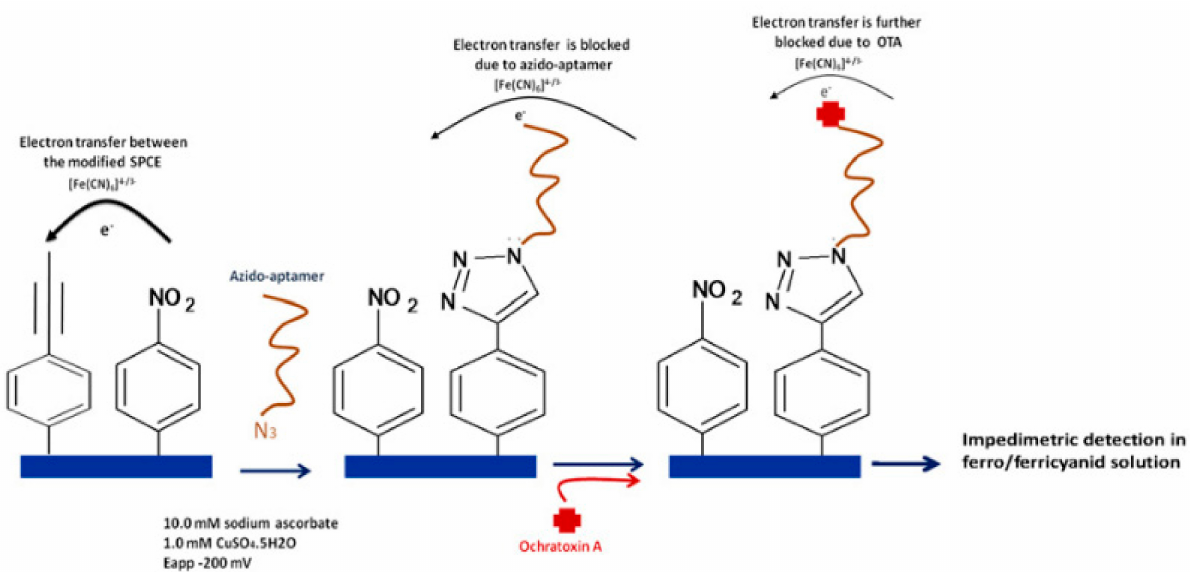
Figure 7. Design and working principle of an impedimetric aptasensor for OTA. The aptamer was immobilized through a “click” reaction at a phenylethynyl layer grafted through diazonium chemistry. Reprinted with permission from [40]. Copyright 2013